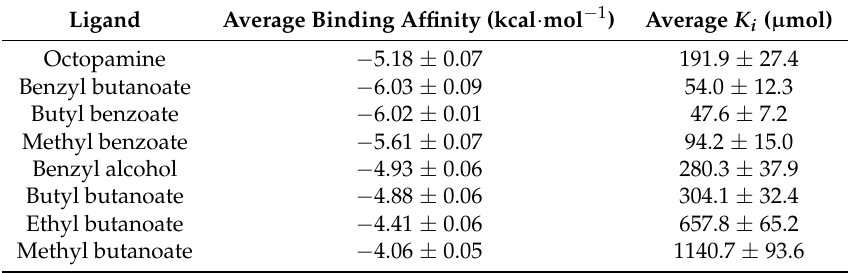
Table 2. Average binding energies of the OAMB-ligand complexes formed and their calculated inhibition constants computed using the Gibbs free energy relation K i = e affinities of the ligands, at 95% confidence level, to OAMB were obtained from the ensemble docking